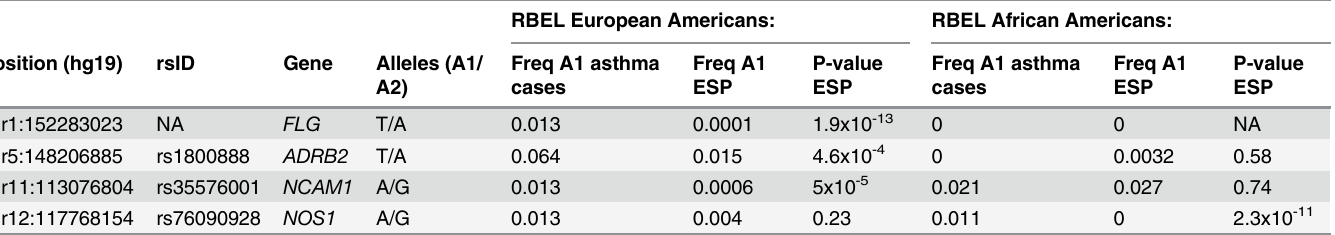
Table 4. Results of allelic association testing for physician-diagnosed asthma following severe RSV bronchiolitis in infancy including genotypes from the Exome Sequencing Project (ESP) as controls. RBEL European Americans: RBEL African Americans: